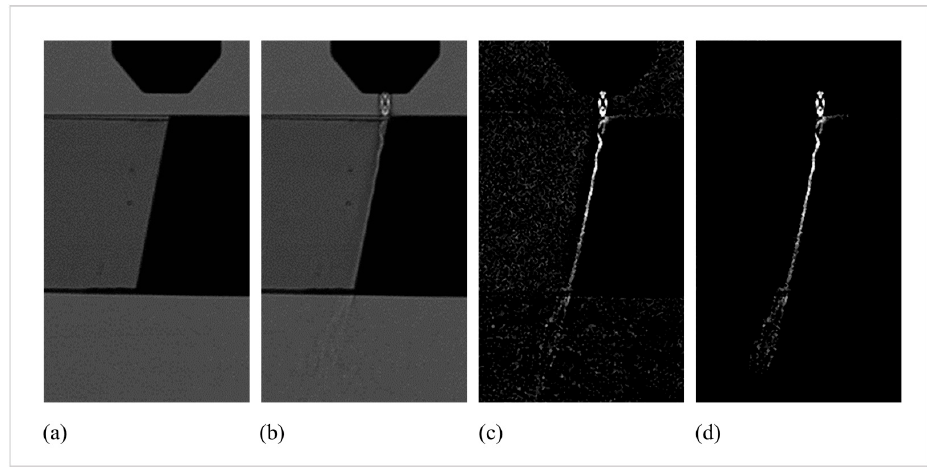
Figure 14. Sequence of image processing. ( a ) Image before gas injection, ( b ) image after gas injection, ( c ) subtracted image, and ( d ) filtered image.